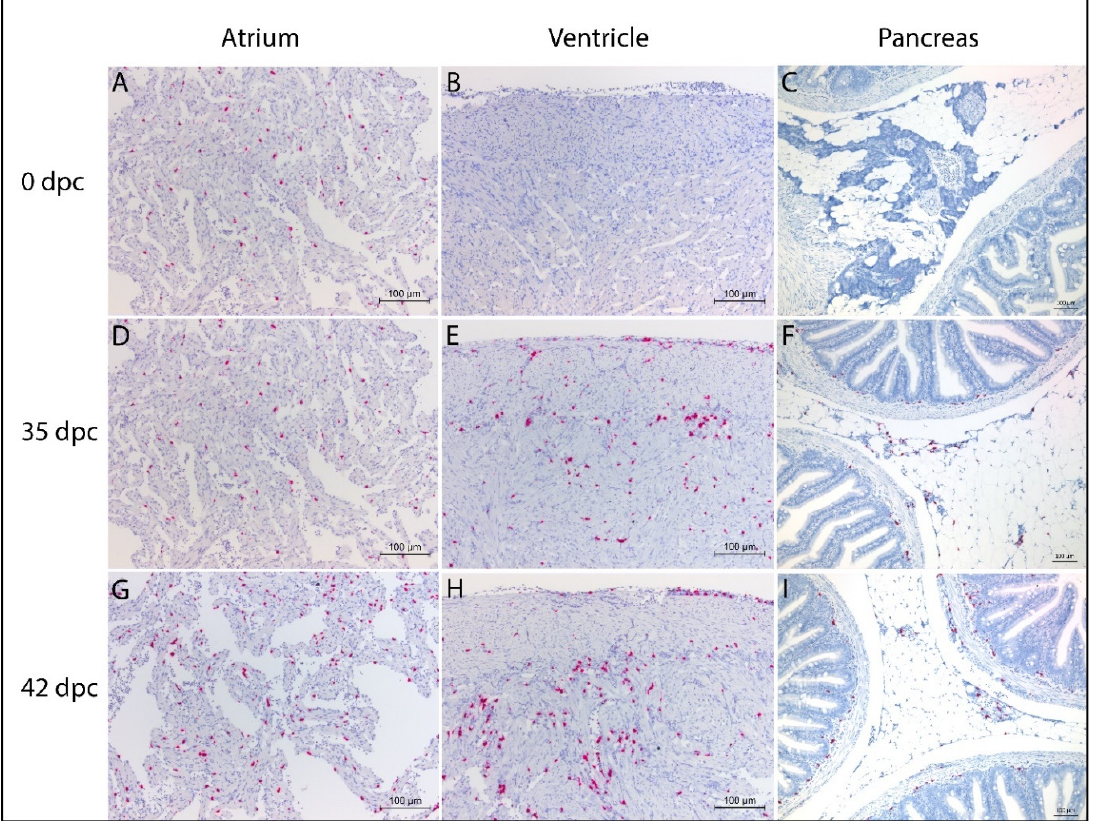
Figure 1. In situ hybridization of immunoglobin (Ig)M transcripts in salmonid alphavirus (SAV)-naïve Atlantic salmon at 0, 35, and 42 days post-SAV challenge (dpc). Images taken from representative individuals within each group. ( A – C ) Many IgM-positive cells in the atrium at 0 dpc. Few and scattered positive cells in the ventricle and pancreas. ( D – F ) Many IgM-positive cells in the atrium at 35 dpc. Substantial amounts of IgM-positive cells in the ventricle and in the exocrine pancreas. ( G – I ) High amounts of IgM-positive cells evident in both the atrium and the ventricle at 42 dpc. IgM-positive cell infiltrates are mainly seen in the stratum spongiosum and in the transition zone between the stratum compactum and the stratum spongiosum . Positive cells also occur in the epicardium. Similar quantities and distributions of IgM-positive cells observed in the pancreas at 42 dpc and 35 dpc.